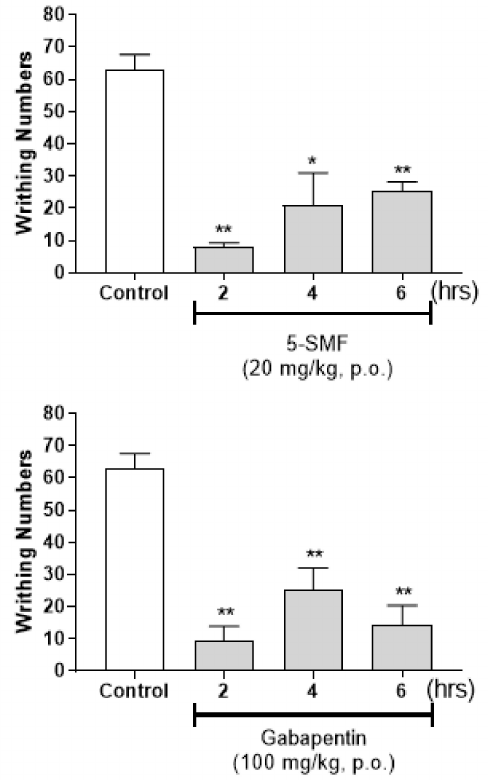
Figure 13. Time-dependent effect of 5-SMF and gabapentin in the acetic acid-induced abdominal writhing test. Data are expressed as mean ± SD; n = 4 mice per group. (* p < 0.01, ** p < 0.001 vs. control